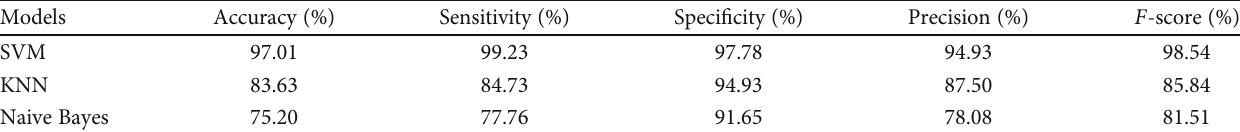
Table 8: Performance of the used machine learning models to predict